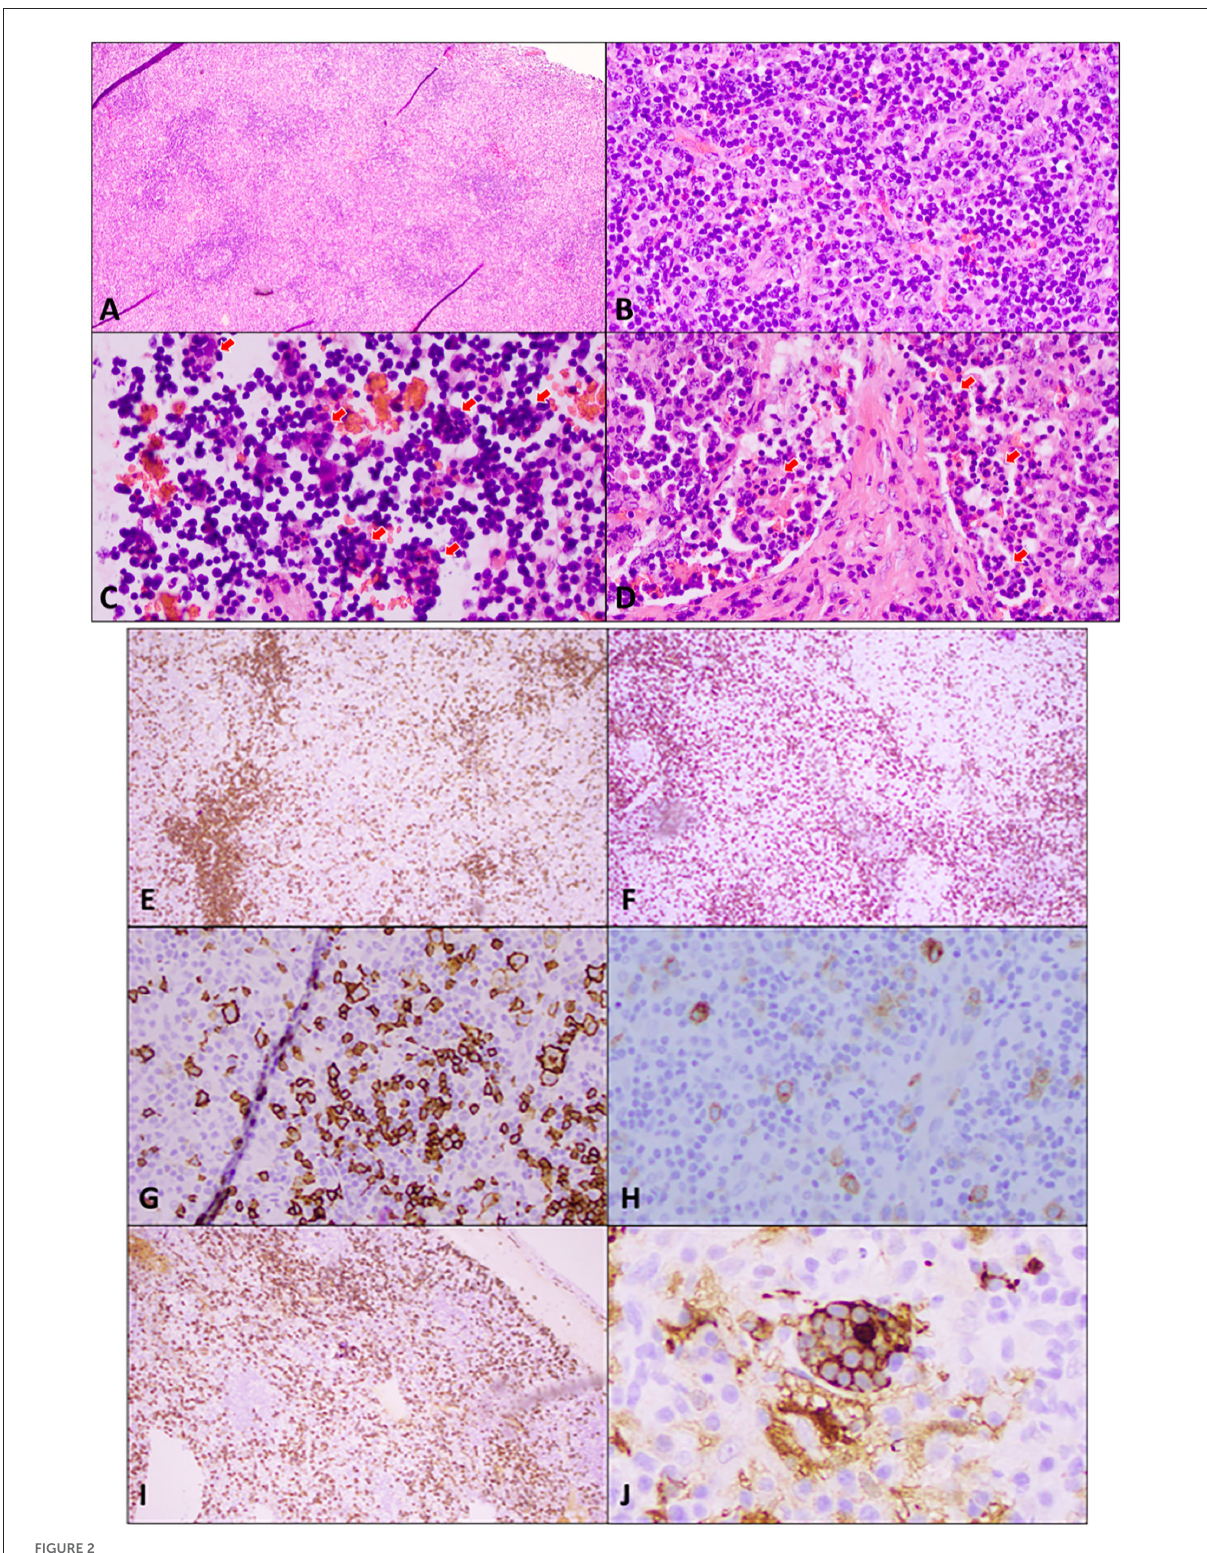
FIGURE2 Excisional biopsy of an enlarged supraclavicular lymph node. (A) Hematoxylin and eosin (H&E) staining at low power (4 × ) shows widely spaced reactive follicles with a prominent paracortex expansion. (B) H&E medium power (20 × ) view demonstrates a mixed small and large atypical lymphocytic infiltrate in the paracortex against the background of abundant plasma cells, immunoblasts, and histiocytes. (C) H&E high power